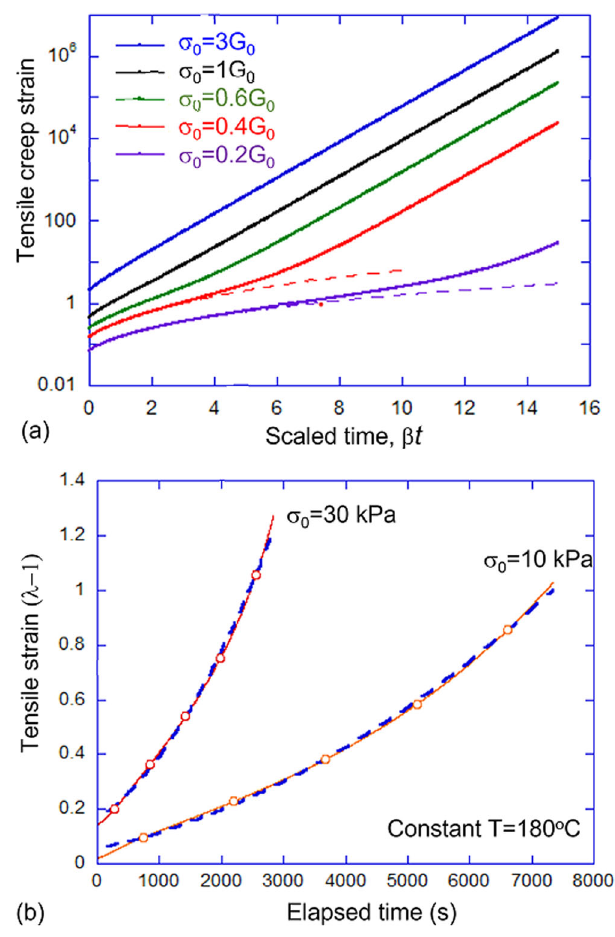
Fig.4|Strainevolutionofvitrimerssubjectedtoaconstantengineeringstress. a Comparisonofthefullnumericalsolutionfor λ ( t )(solidlines)fordifferentvalues ofconstantstress σ 0 .Forcomparison,theapproximateexpression(11)viathetime- series (dashed lines) is shown for low-stress curves. b Experimental measurement of plastic creep under low constant stress, for the Leibler's benchmark vitrimer, at T =180 ∘ C. Dashed lines show the fi tting with Eq. (11), giving the fi tting parameter β =0.016s − 1